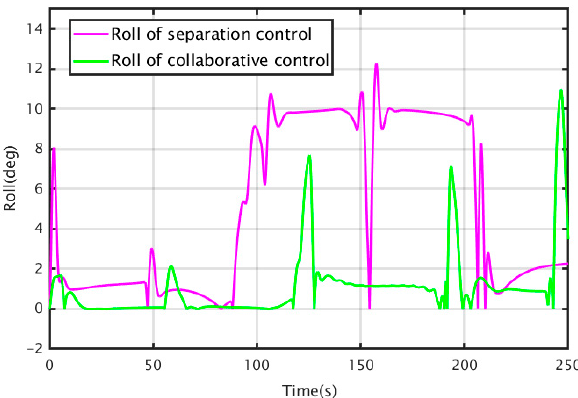
Figure 13. Comparison curves of roll angle of four-point navigation.